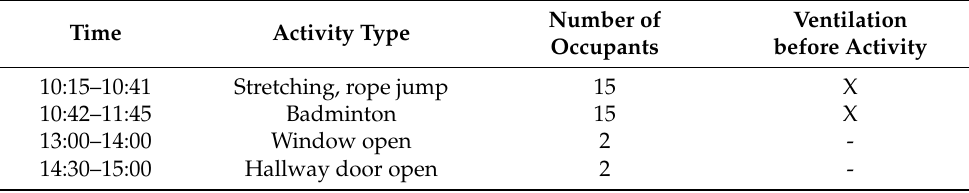
Table 9. Activity schedule of the MPA-space of A elementary school on 18 November 2020.